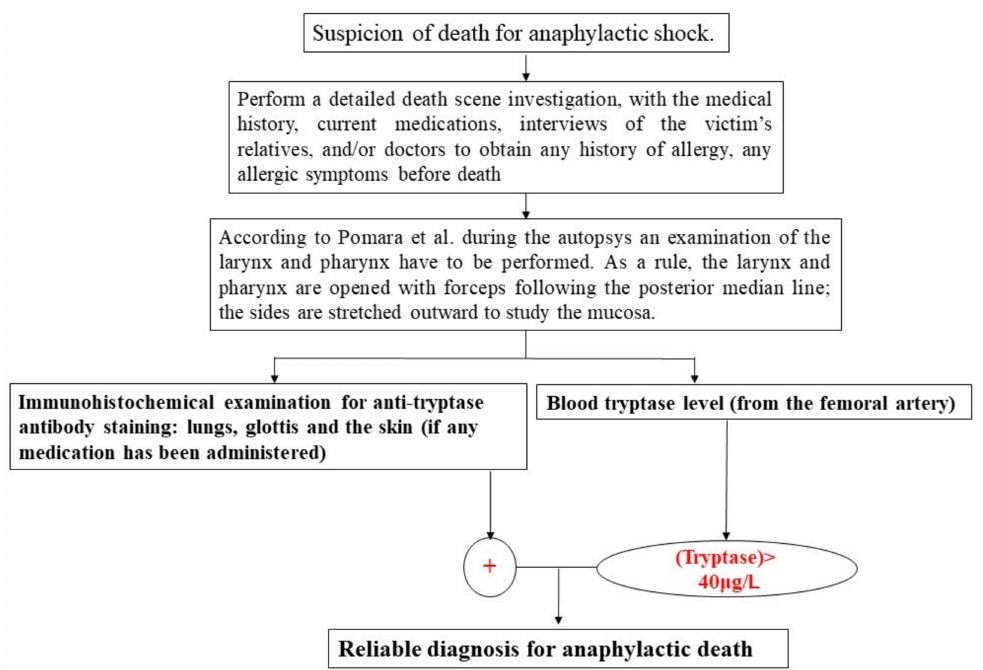
Figure 5. Proposed workflow to detect anaphylactic shock in fatal cases. In red text the goal of the flow